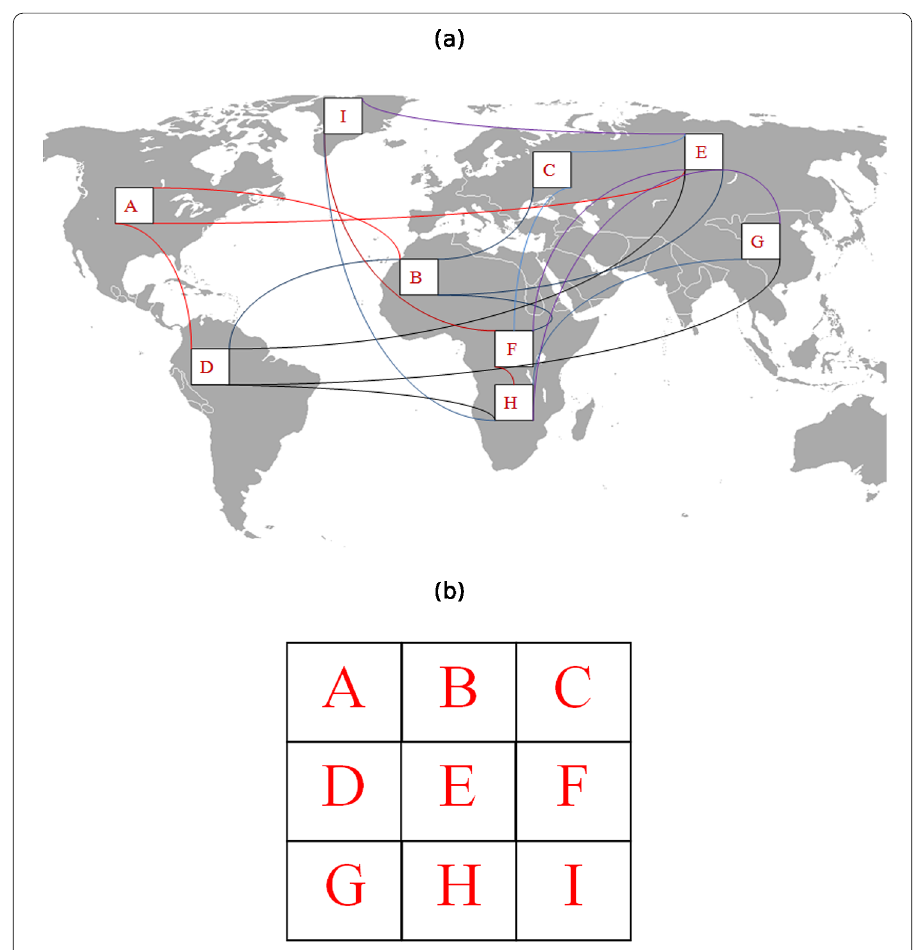
Figure 1 (a): Infection travel connections between nine separated geographical regions located at different continents. (b) : Assembly of the regions in one grid of nine numbered